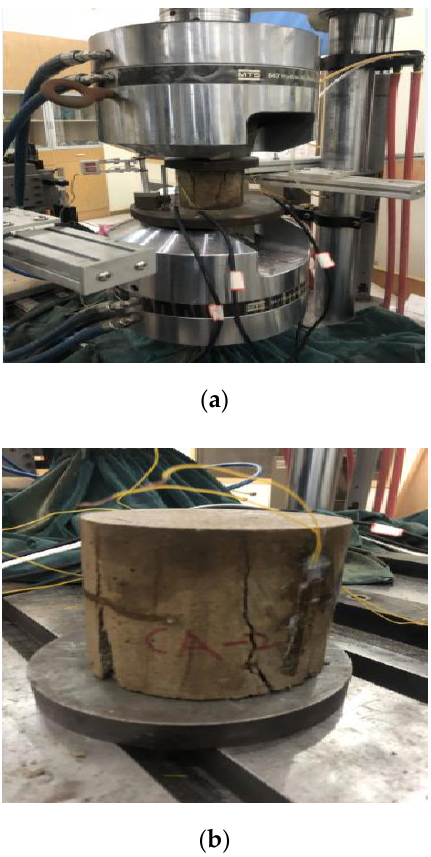
Figure 3. The monotonic compression test for CA mortar: ( a ) The monotonic compression test; ( b ) Typical failure mode for CA mortar.